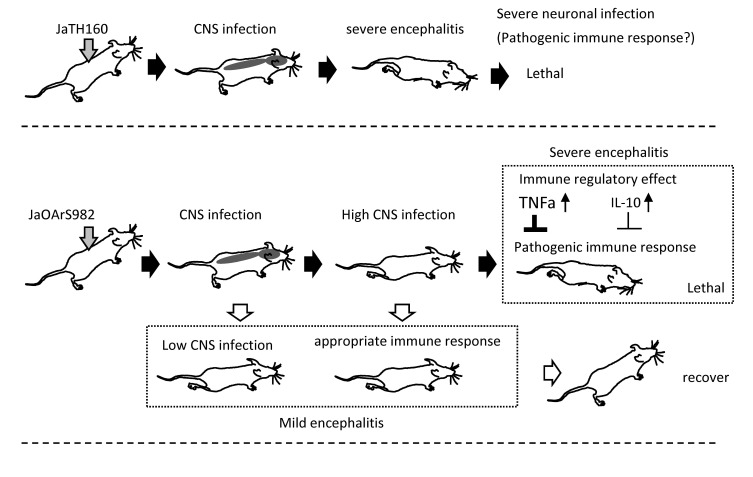
Proposed model of the mechanism of fatal disease following JEV infection in a mouse model.